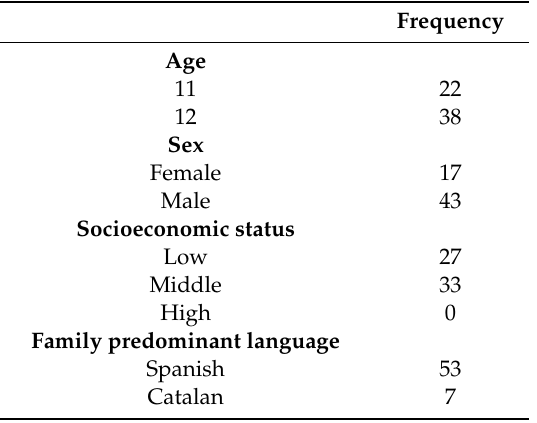
Table 1. Sociodemographic data of the